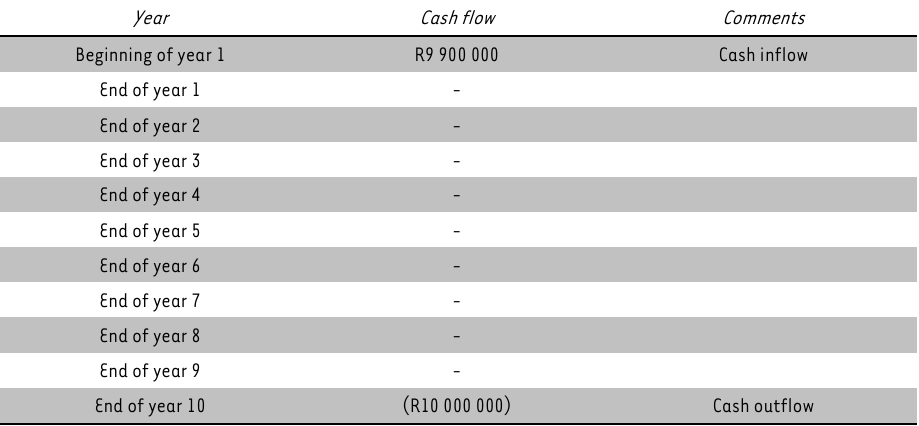
Cash flow schedule Year Cash flow